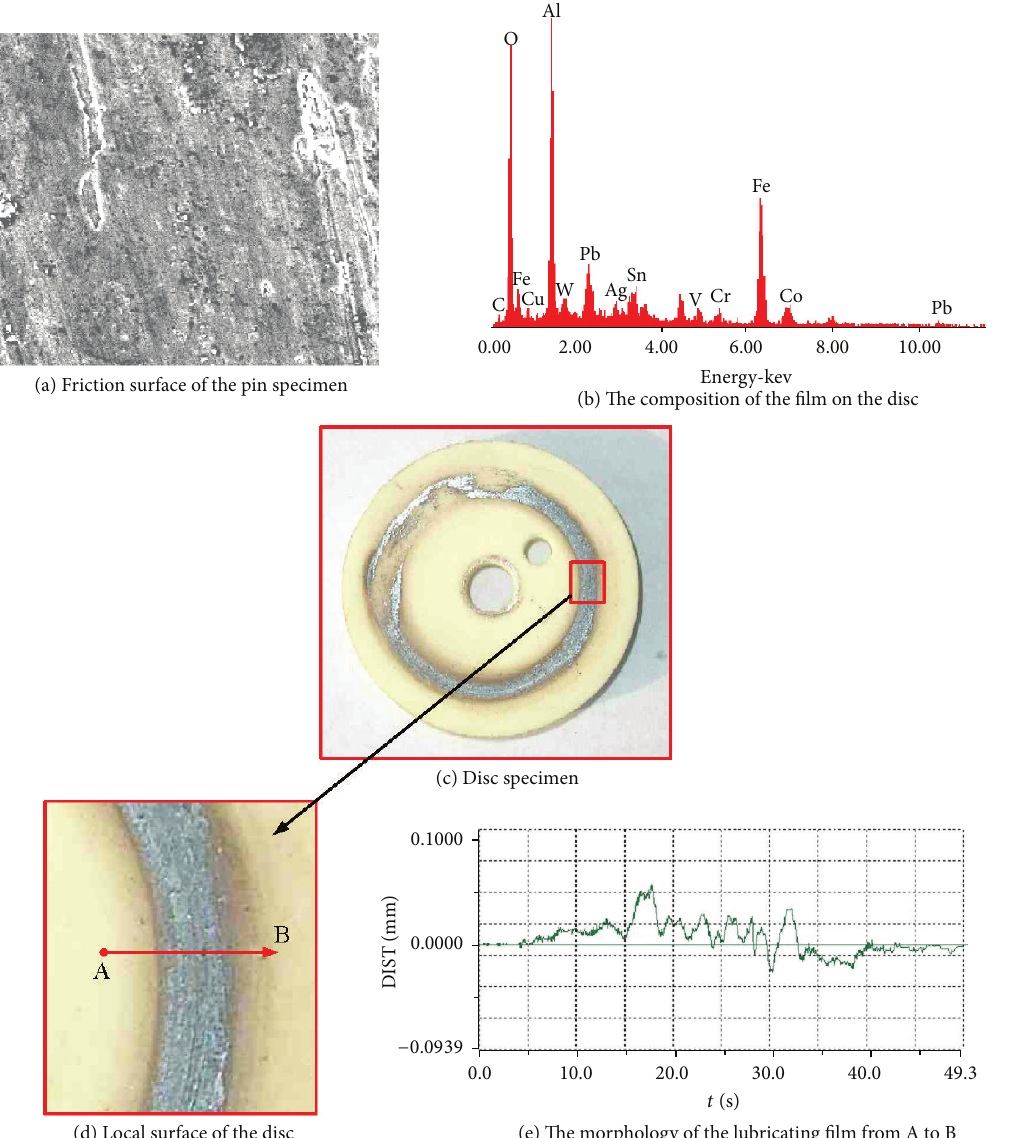
Figure 9: Lubricating film on the friction